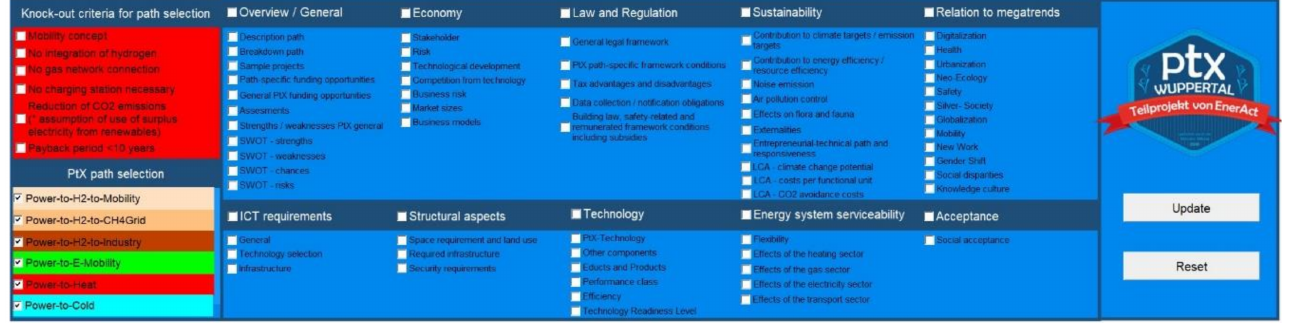
Figure 3. Graphical interface of the evaluation